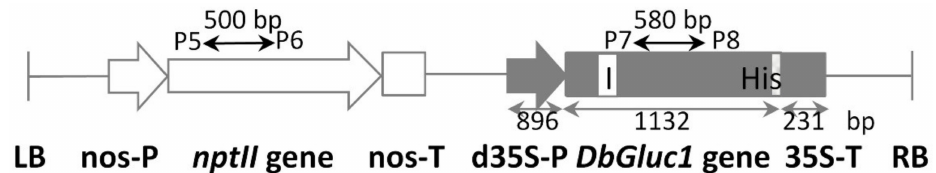
Figure 2. Schematic diagram of the T-DNA (transfer DNA) region of the vector construct pDbGlucBin+ (not to scale). The gene for D. binata β -1,3-glucanase ( DbGluc1 gene) was under the control of the double CaMV35S promoter (d35S-P) and terminated by the CaMV35S terminator (35S-T). The gene for neomycin phosphotransferase ( nptII gene) was driven by the nopaline transferase promoter (nos-P) and nos terminator (nos-T) sequence. The intron and His-tag sequences are marked by (I) and (His), respectively. Black arrows indicate the position of the primers used for PCR